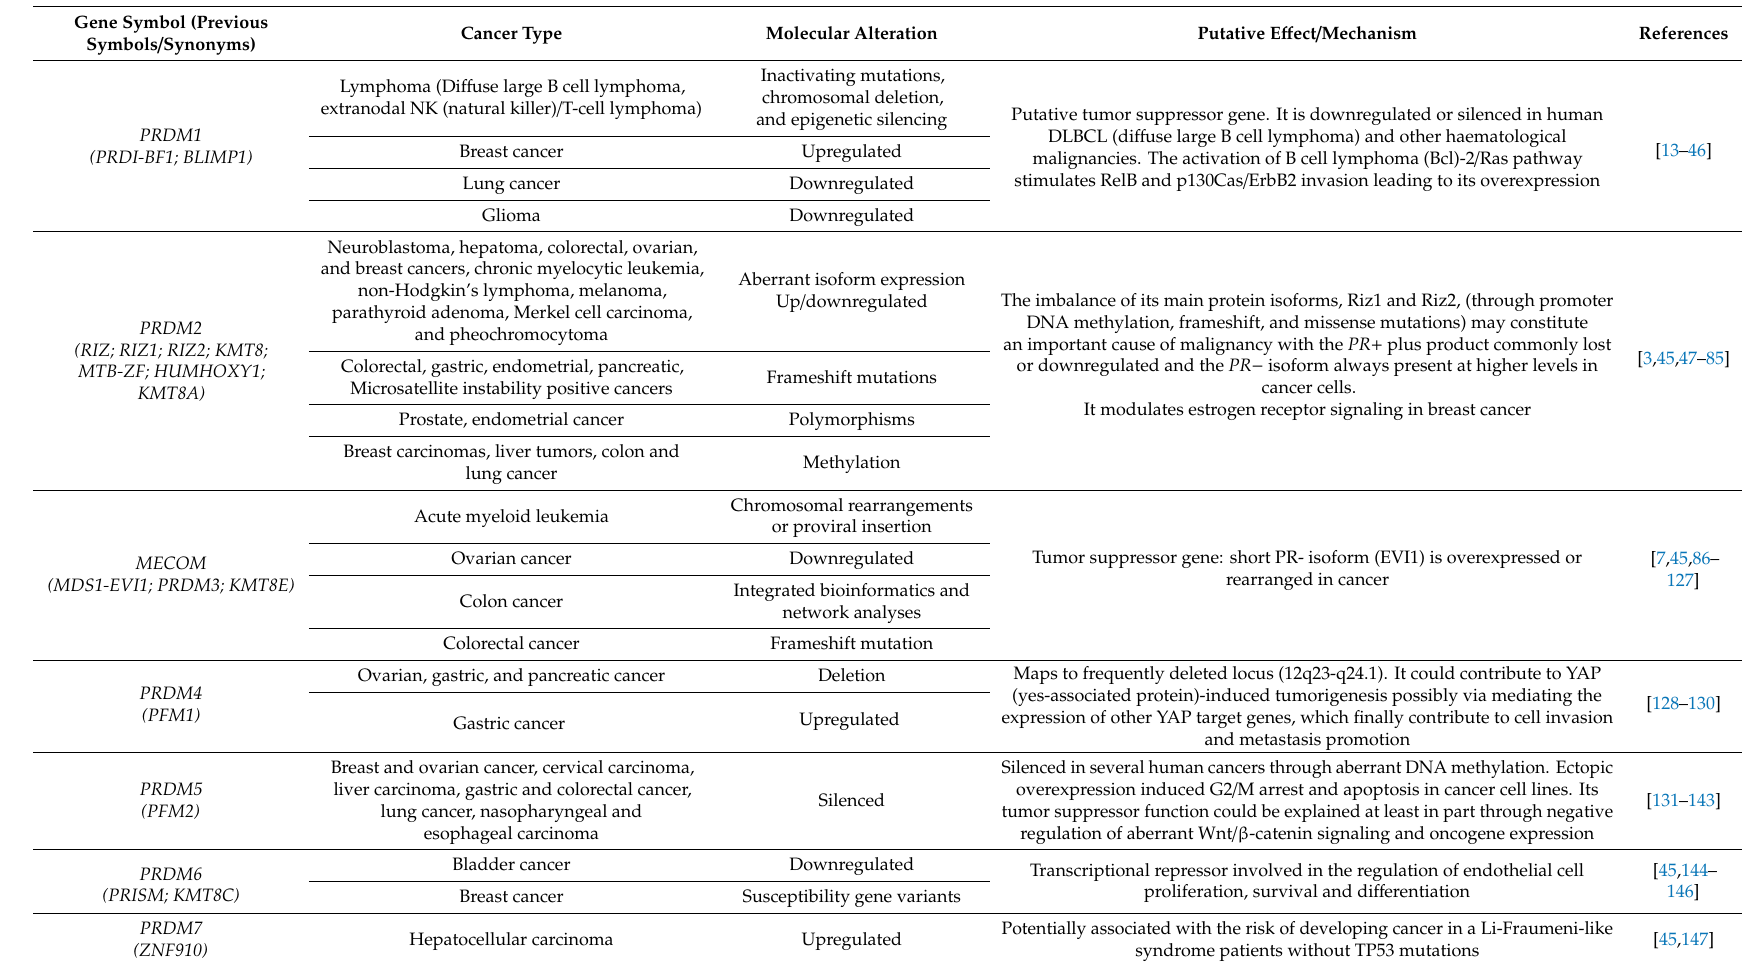
Table 1. Cancer specific alterations of PRDM family